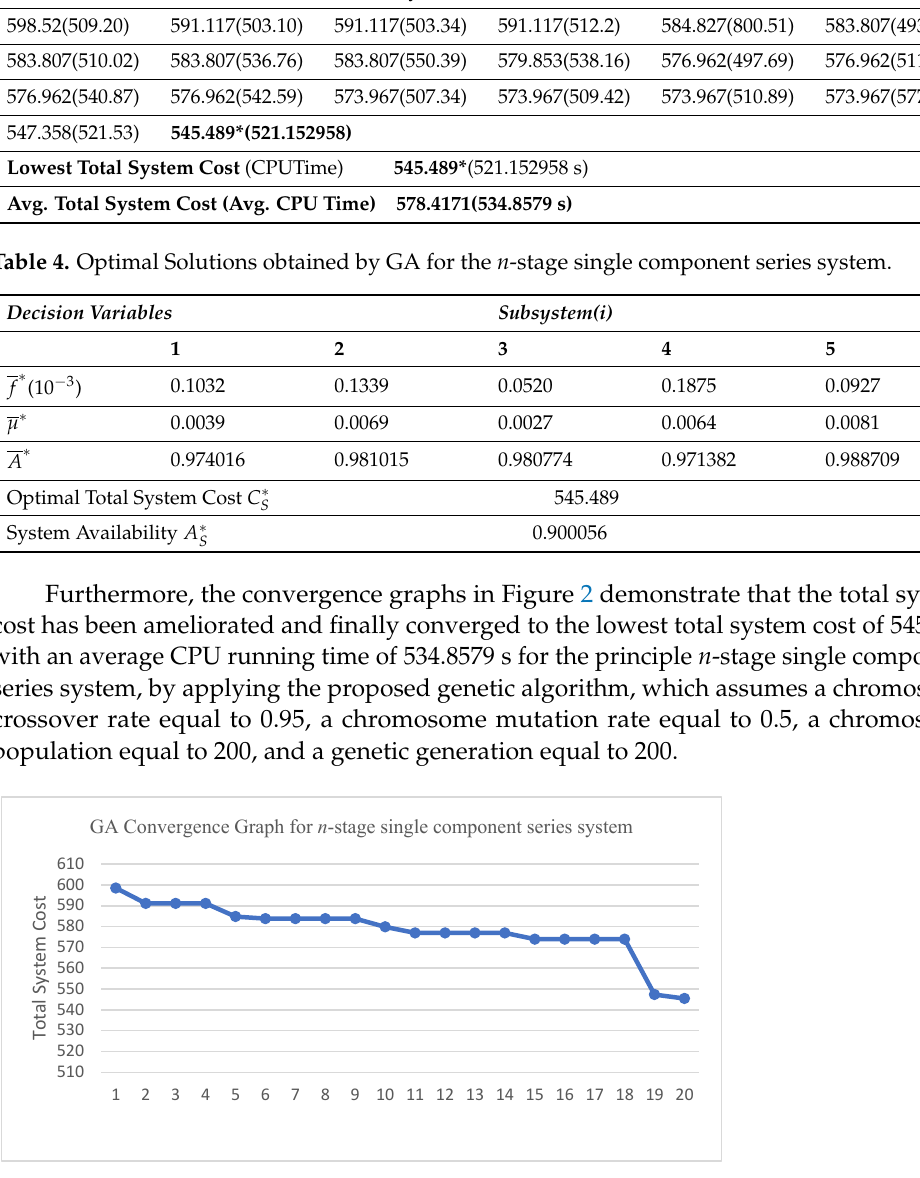
Table 3. The total system costs of 20 simulation runs by GA for the n -stage single component series system. Total System Cost (CPU Time)